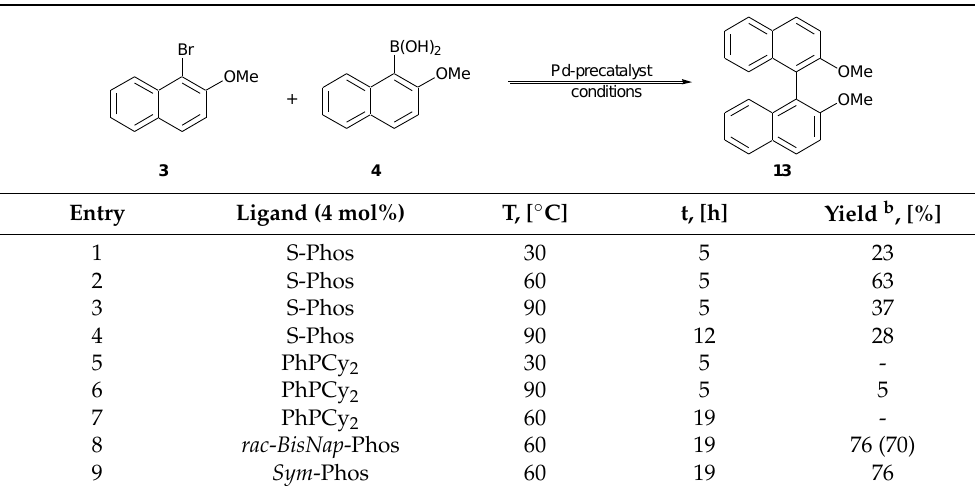
Table 1. Synthesis of 2,2-dimethoxy-1,1 ′ -binaphthyl ( 13 ) mediated by different ligand complexes a